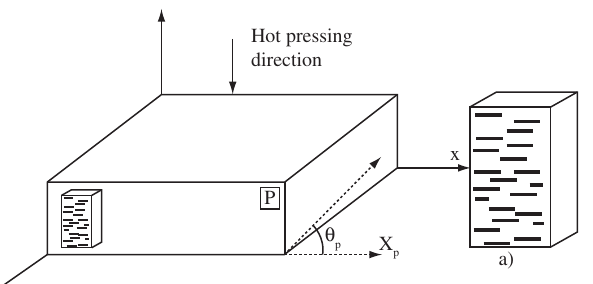
Figure 2. Schematic figure of a hot-pressed sample with preferential grain orientation in the plane parallel to the hot pressing direction (P). θ the angle of grain orientation in the P plane.